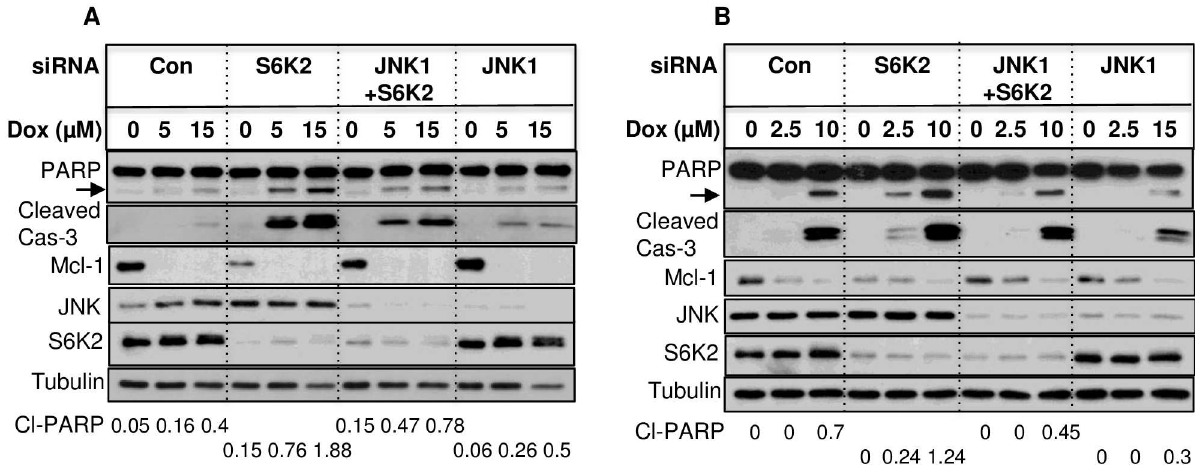
Fig 8. Knockdown of JNK1 attenuates increasein doxorubicin-induced apoptosis caused by S6K2 knockdown. T47D (A) or HCC1428(B) cells were transfected with indicatedsiRNAs for approximately 48 h and then treated with or without doxorubicin for approximately 24 h. Western blot analysiswas performed with indicatedantibodies. The arrow indicatescleaved PARP. Results are representative of 2 (HCC1428) to 3 (T47D) independent experiments. The bands corresponding to cleavedPARP were quantifiedusing ImageJ and the intensitiesof cleavedPARP normalized with tubulin are